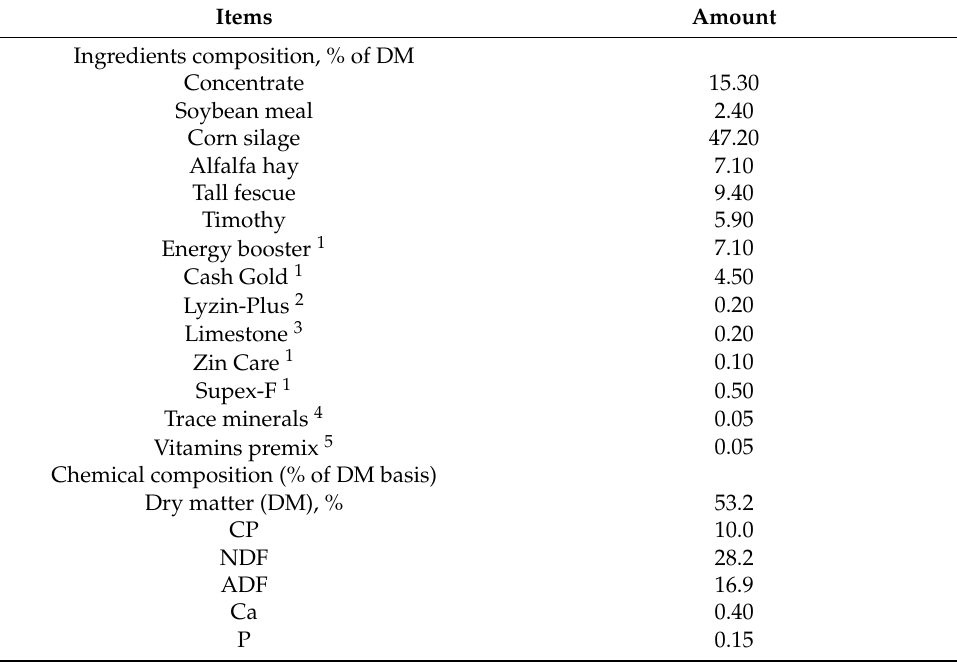
Table 1. Ingredients and nutrients of the experimental